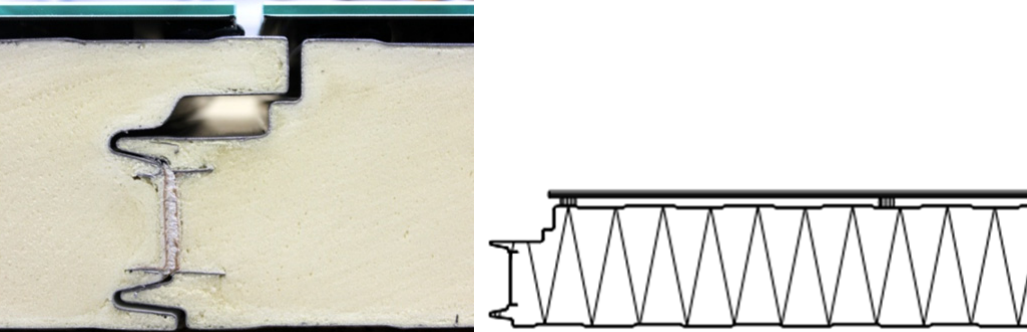
Fig. 3 Typical section through glass sandwich panel with polyurethane core (Brucha FP-P sandwich panel).